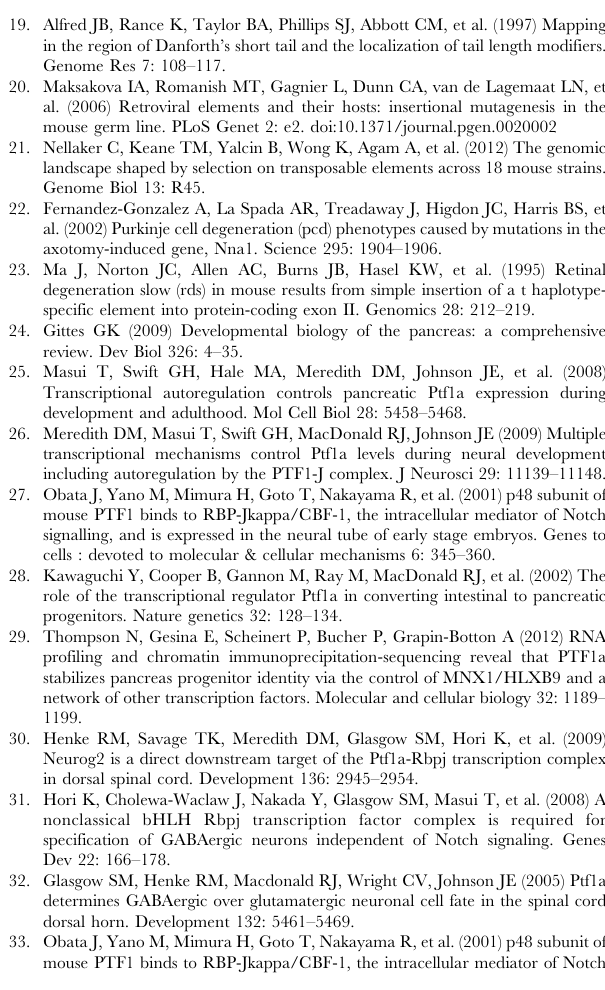
Figure S1 Multipoint lod score map of the Sd locus. (PDF) Figure S2 Quantitative PCR of PTF1a targets in whole embryo at E9.5. (JPG) Table S1 Annotated sequence of the ETn insertion at the Sd